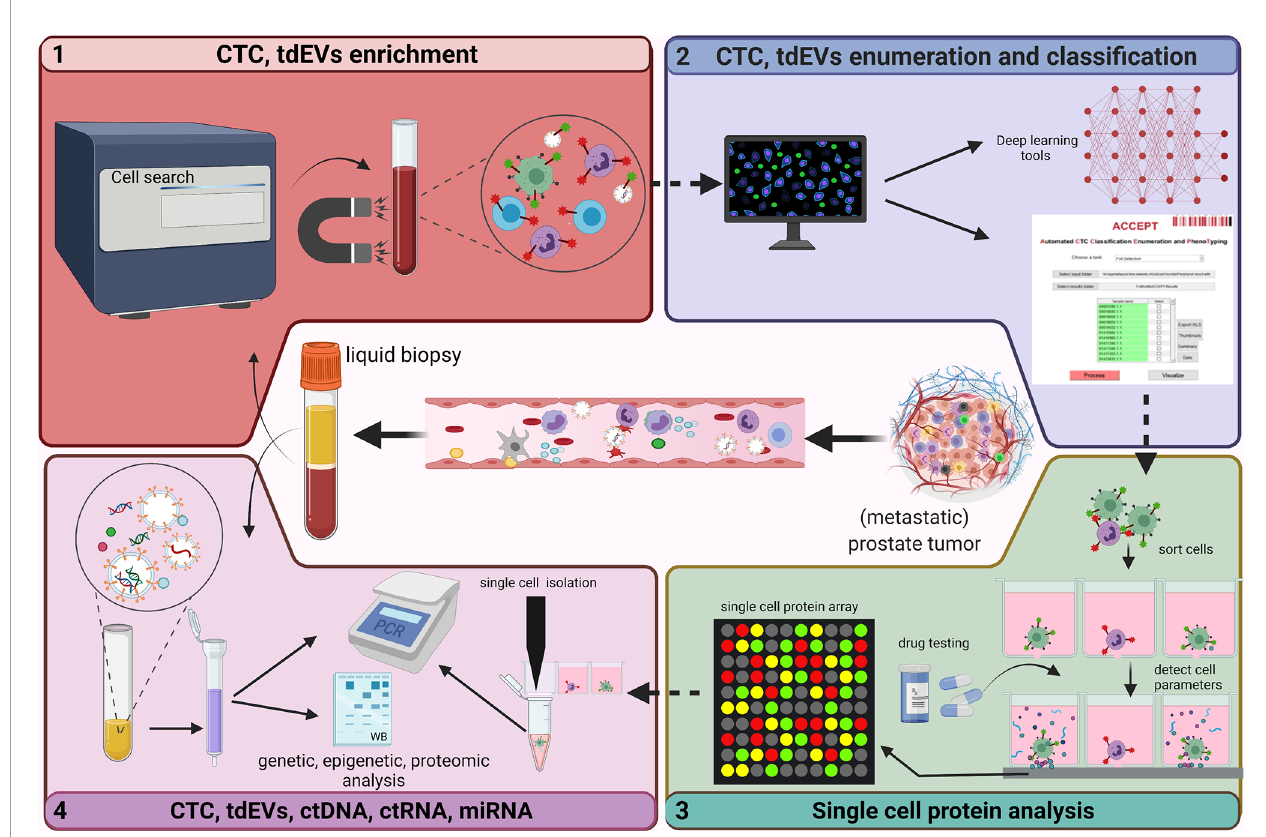
FIGURE 3 | Analysis of circulating biomarkers. This fi gure depicts the technologies (developed and used at the Medical Cell BioPhysics Department at the University of Twente) that are generally used to identify/analyze circulating biomarkers in liquid biopsy. The FDA approved CellSearch (immunomagnetic enrichment) is the gold standard and is currently used for the CTC and tdEV enrichment from prostate cancer patient diagnostic leukapheresis (DLA) sample (1). An in-house developed tool - Automated CTC Classi fi cation Enumeration and PhenoTyping (ACCEPT) - is used to classify and enumerate the CTCs and tdEVs to better understand the morphology and phenotypic heterogeniety. Other deep learning tools such as Deep or Recurrent Convolutional Neural Networks (DCNN or RCNN) based algorithms were developed with improved segmentations models for automated and bias-free CTC enumeration (2). Enriched CTCs are further sorted into single cells using microwell arrays, analyzed for protein secretions in response to treatments, after which CTCs of interest are isolated (3). Omics pro fi ling of selected CTCs and other circulatory markers including tdEVs, ctDNA, ctRNA and miRNA using polymerase chain reaction (PCR) and low-pass whole genome sequencing (LP-WGS) is performed to identify aberrations and analyze tumor heterogenity and aggressiveness (4). Created with